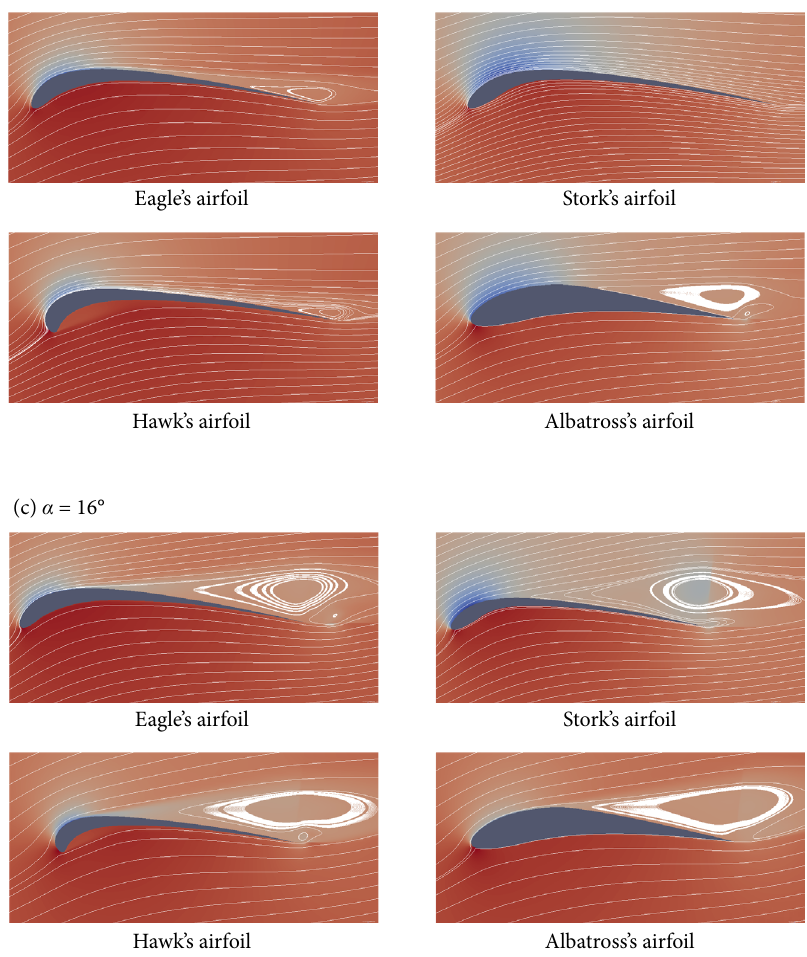
Figure 9. Exhibition of streamlines at different angles of attack for all four bird’s